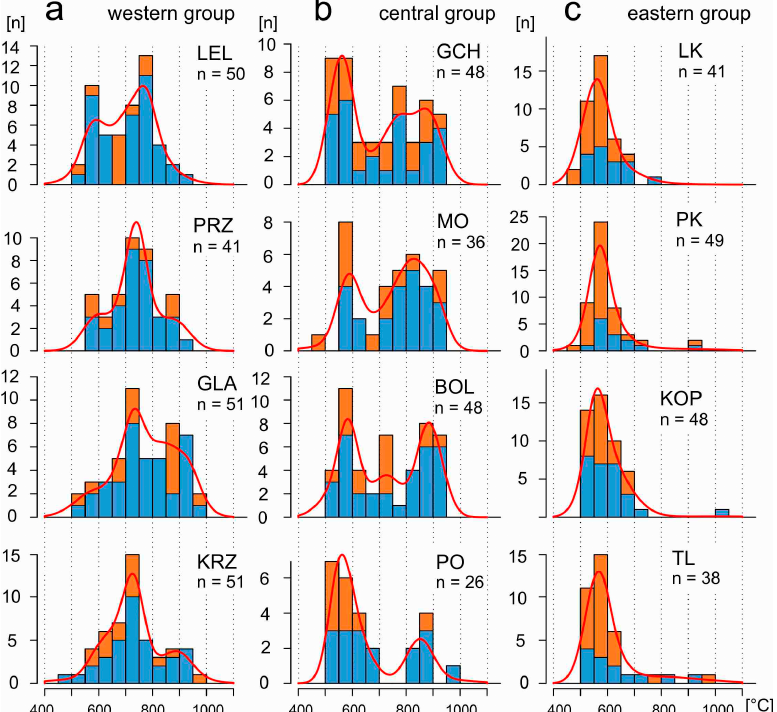
Figure 5. Histograms of rutile crystallization temperatures for all samples in the three groups: western ( a ), central ( b ), and eastern ( c ). Details of sample abbreviation and localization in Table 1. Temperatures were calculated using the [32] formula. Blue colour—metapelitic rutile; orange colour—metamafic rutile.